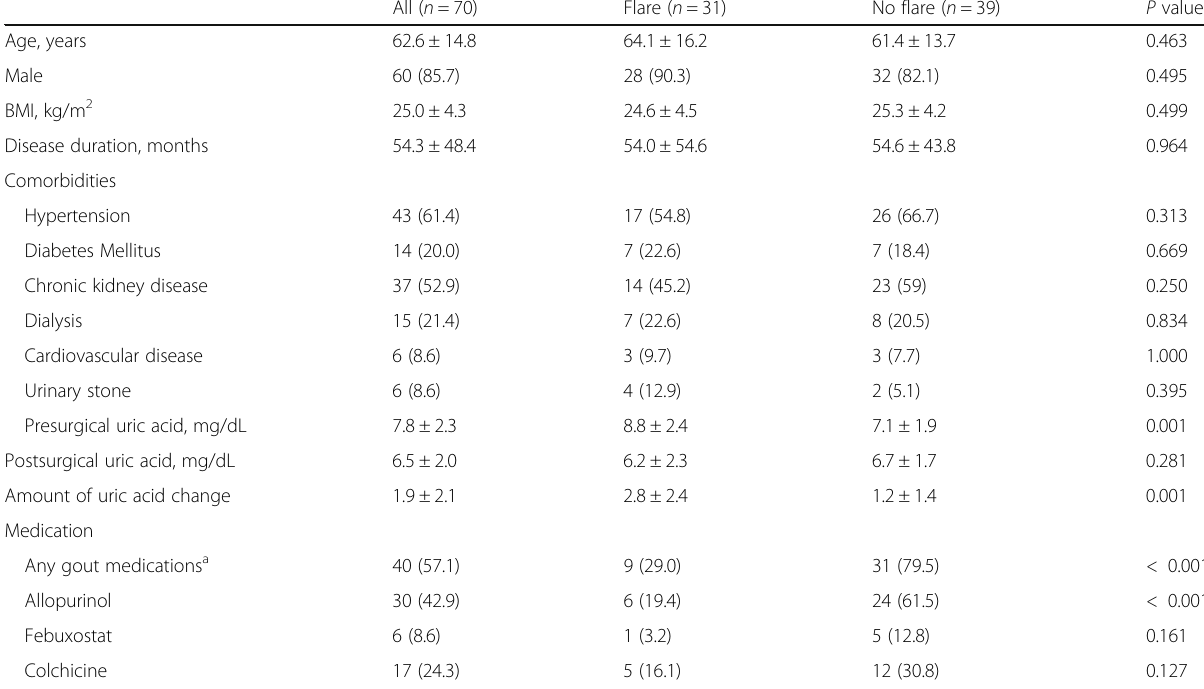
Table 1 Comparison of characteristics between patients with gout flare and without gout flare